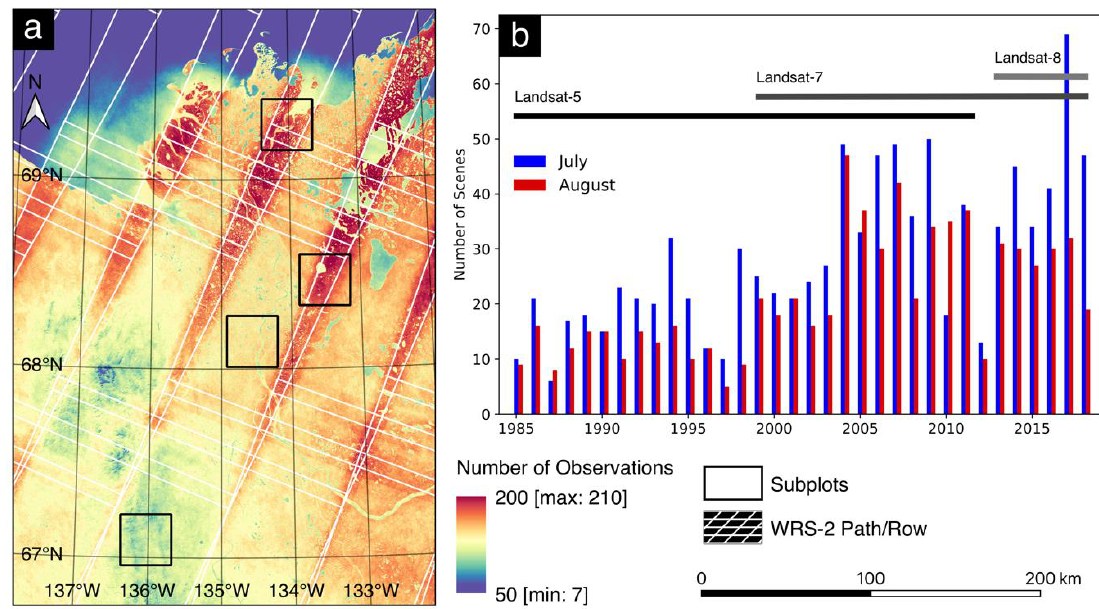
Figure 2. Landsat observations: ( a ) pixel-based number of cloud-free summer (July/August) observations between 1985 and 2018; ( b ) number of scenes per month. Subplots from Figure 1 are highlighted by the black polygons.